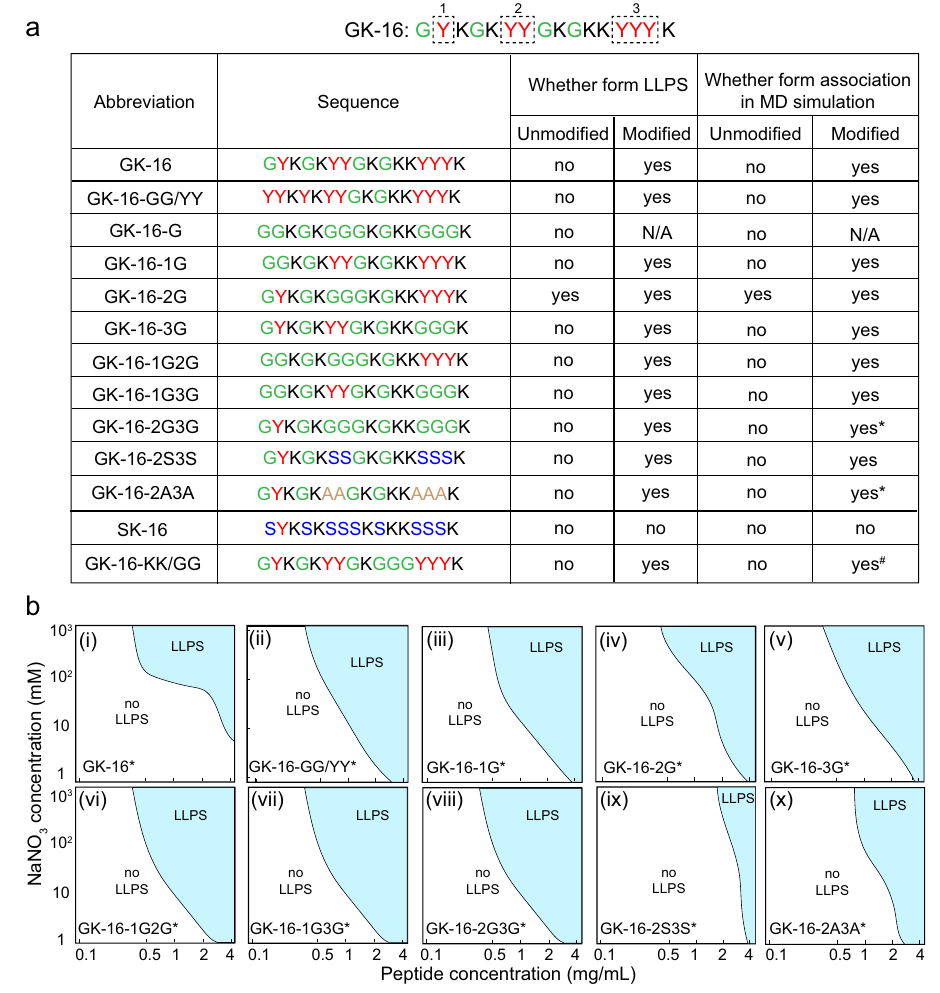
Fig. 4 | LLPS behaviors of mutated GK-16* variants. a The list of GK-16* variants with modi fi ed sequences, and corresponding LLPS and association behaviors in experiments and MD simulations. Lines with * and # represents 900 and 300mM ionic strength respectively, the others were under 500mM ionic strength to